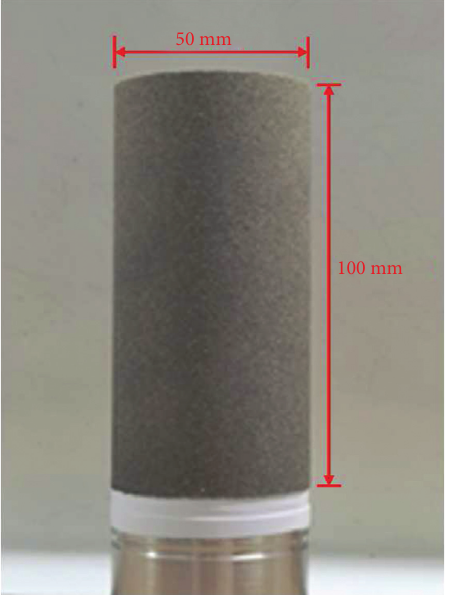
Figure 2: Image of triaxial test